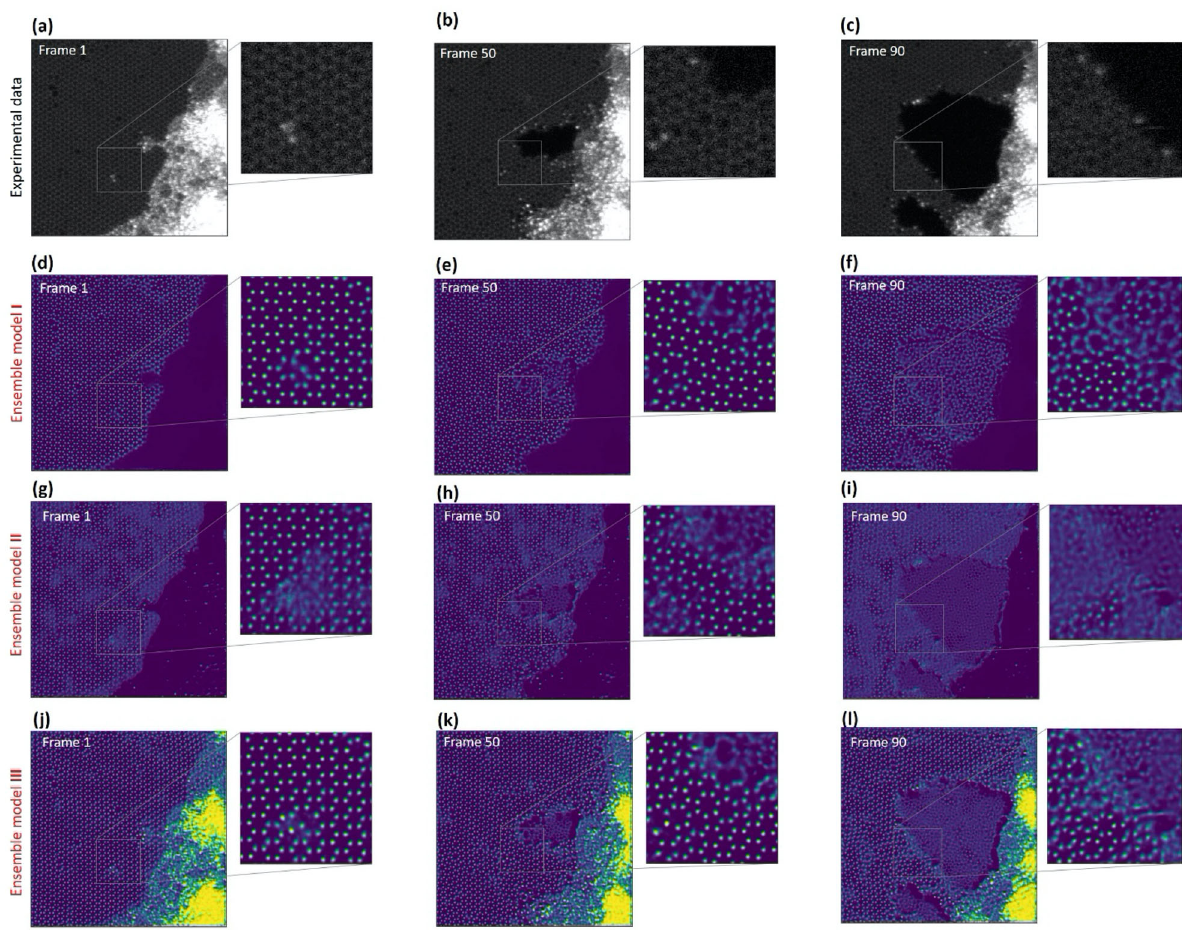
Fig. 3 Application of ensemble models trained on simulated data to real data. Predictions in a form of semantically segmented maps from different ensemble models for frames 1 ( a , d , g , j ), 50 ( b , e , h , k ), and 90 ( c , f , i , l ) of the experimental movie from 2D graphene with